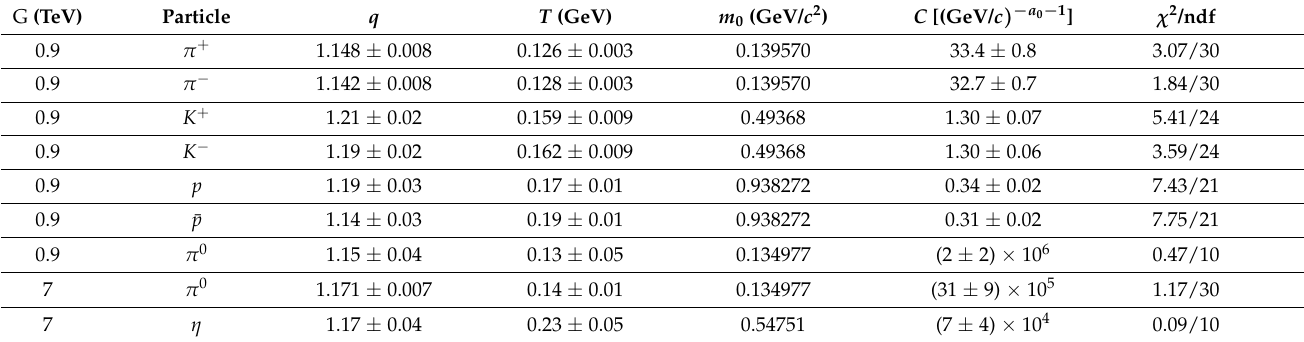
Table 4. Best-fit parameters of the Tsallis–Pareto Formula 3, where the parameter a o = 1 is fixed. For details, see Table 1.